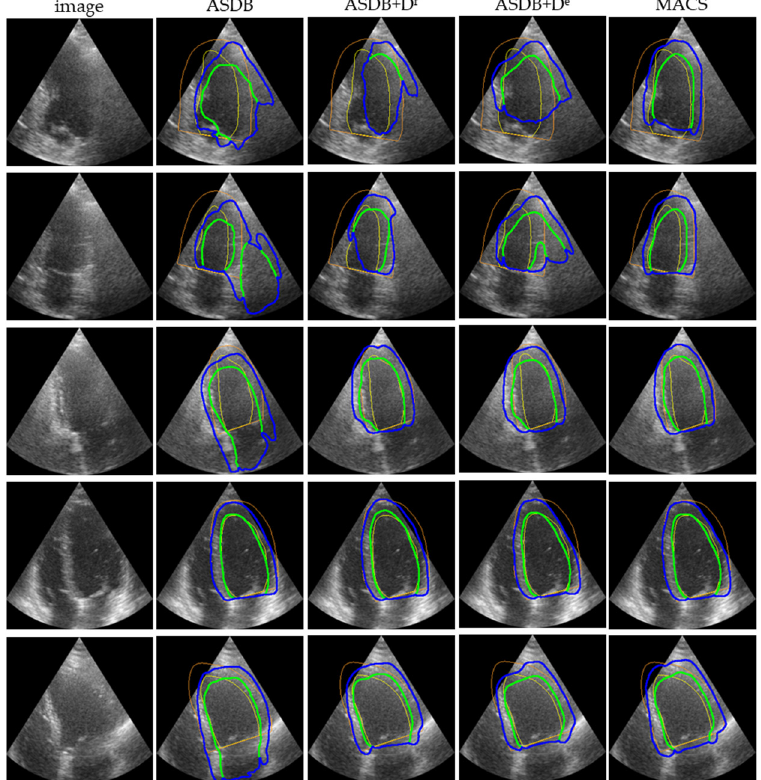
Figure 4. Representative visual segmentation results of the ablation study. Different model configurations are compared, including the ASDB, the ASDB + Feature discriminator (D f ), the ASDB + Entropy discriminator (D e ), and the full framework of the MACS. The green and blue contours indicate boundaries of the LV endo and LV epi , respectively. The yellow and orange colors denote the ground truth. Table 1. Ablation studies on the proposed MACS. The fully domain adaptation (DA), entropy do- main adaptation (EDA) and feature domain adaptation (FDA) are ablated, respectively. The up ar- row indicates expecting a higher value.